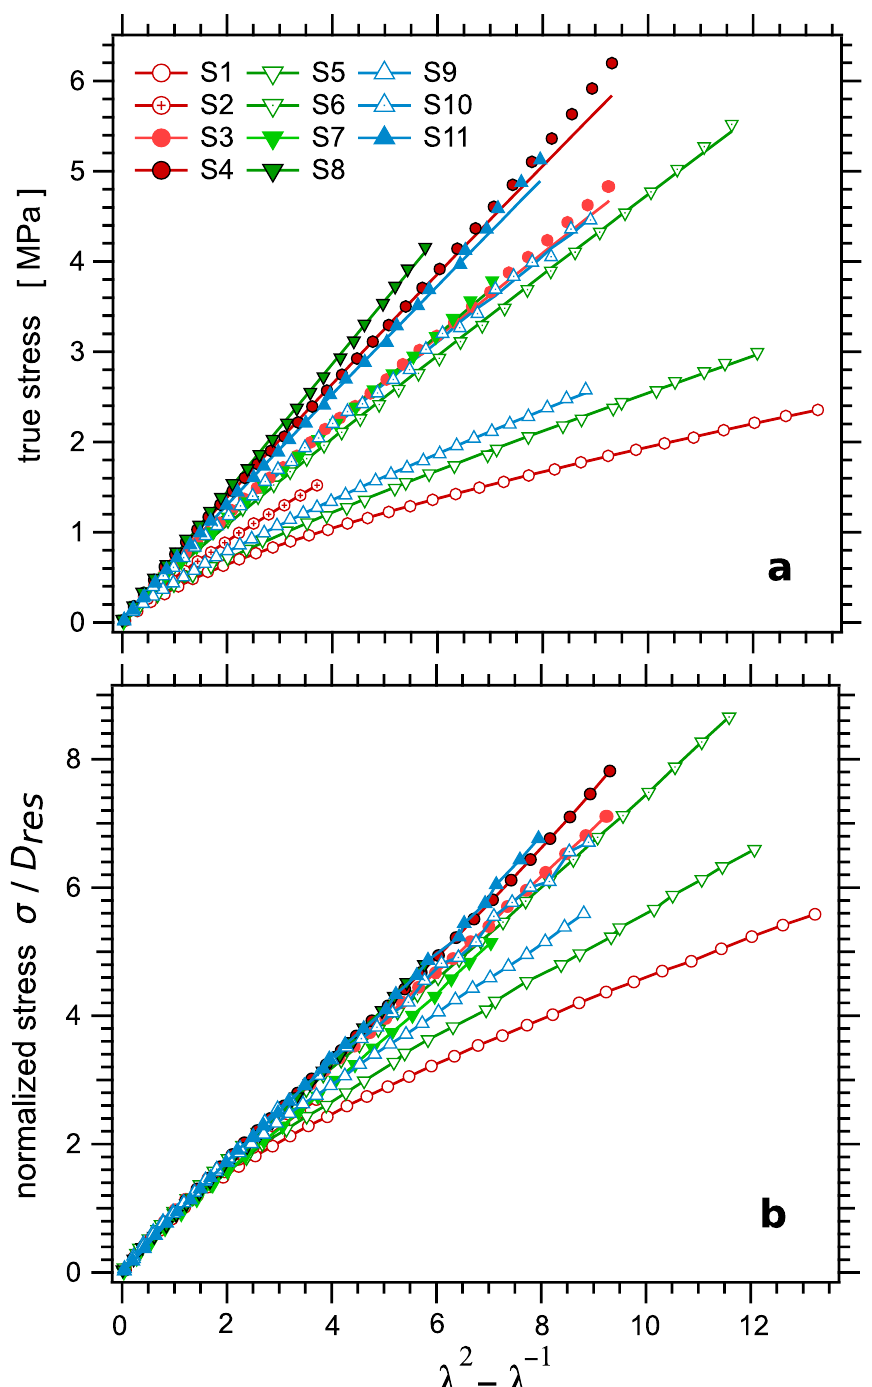
Figure 10. ( a ) The true stress σ as a function of the elongation parameter λ 2 − λ − 1 for the series of crosslinked samples. Symbols are experimental points, curves are Mooney–Rivlin fits, according to Equation (16). The graph illustrates the upwards deviation affecting some of the curves at high stress. ( b ) The normalized stress σ / D res as a function of the elongation parameter λ 2 − λ − 1 for the series of crosslinked samples. As expected, the curves superpose in the low strain regime, up to about 60%